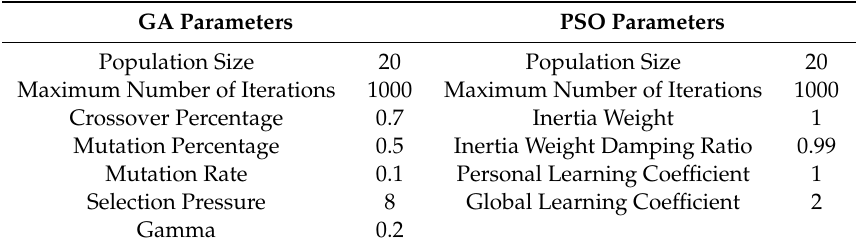
Table 2. Genetic algorithm (GA) and particle swarm optimization (PSO) algorithm